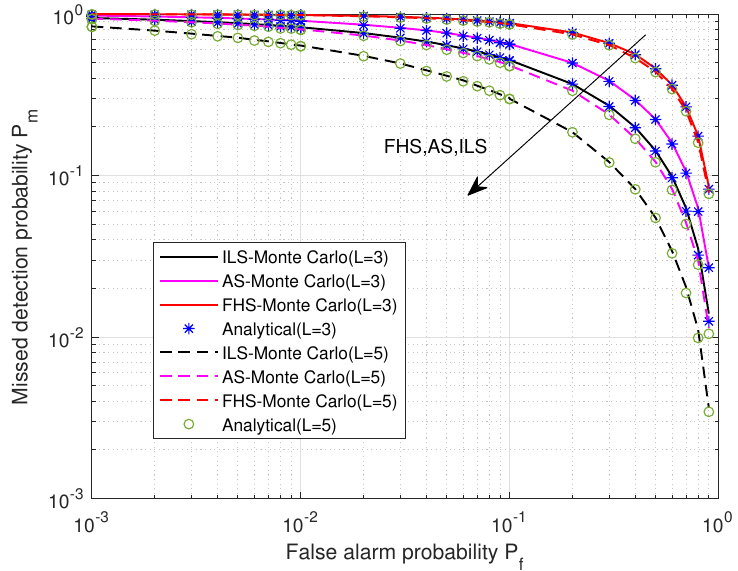
Figure 7. The probability of miss detection P m versus the false alarm probability P f for different shadowed-Rician fading values.